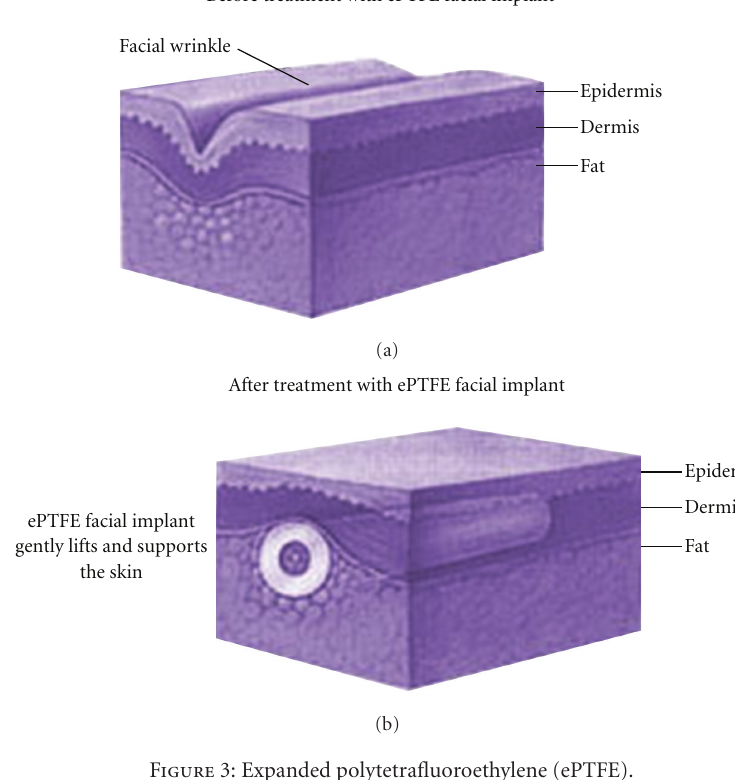
Figure 3: Expanded polytetrafluoroethylene (ePTFE).